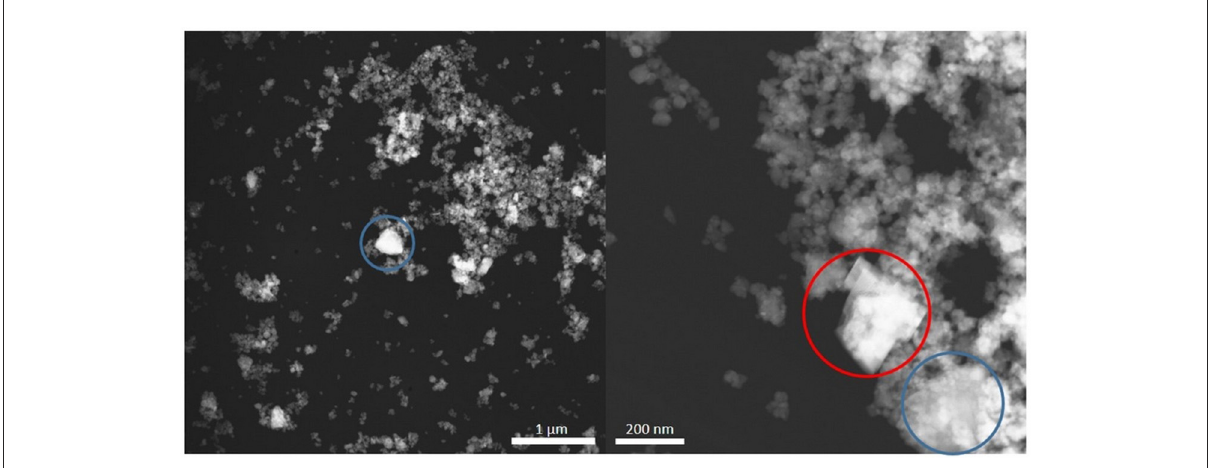
FIGURE12 STEM micrograph of a FIB section of carbonation products obtained in AC mode after 24h (red circle: carbonates, blue circle: residual